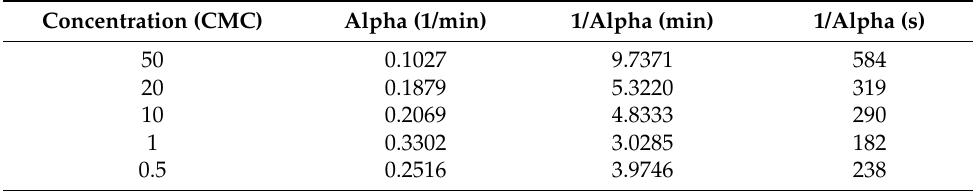
Table 7. The characteristic time scale obtained using Equation (4) for foams produced using SDS solutions with 15 dH hard